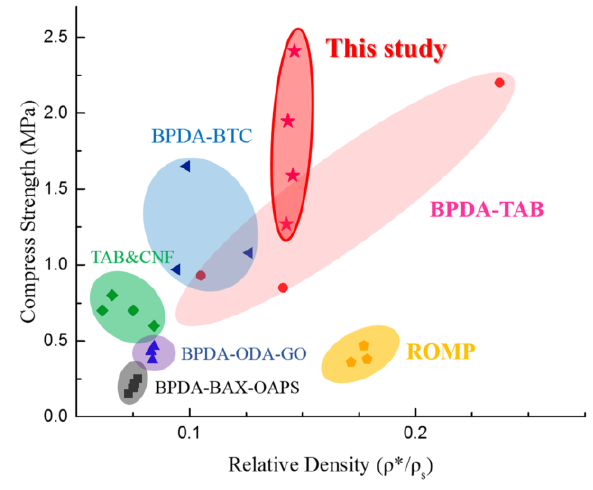
Figure 9. Comparison of aerogels’ compression strength in this study compared to others’ previous work.